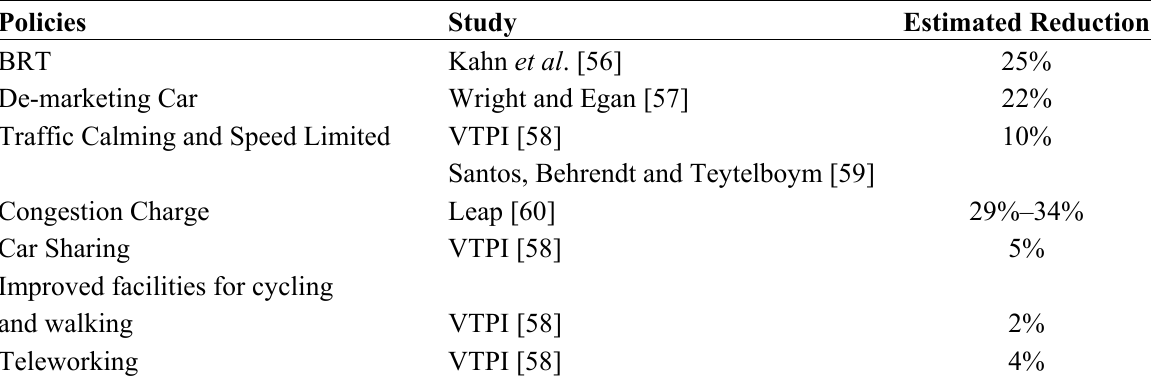
Table 9. Summary of low cost, low technology policies in order to reduce IMT